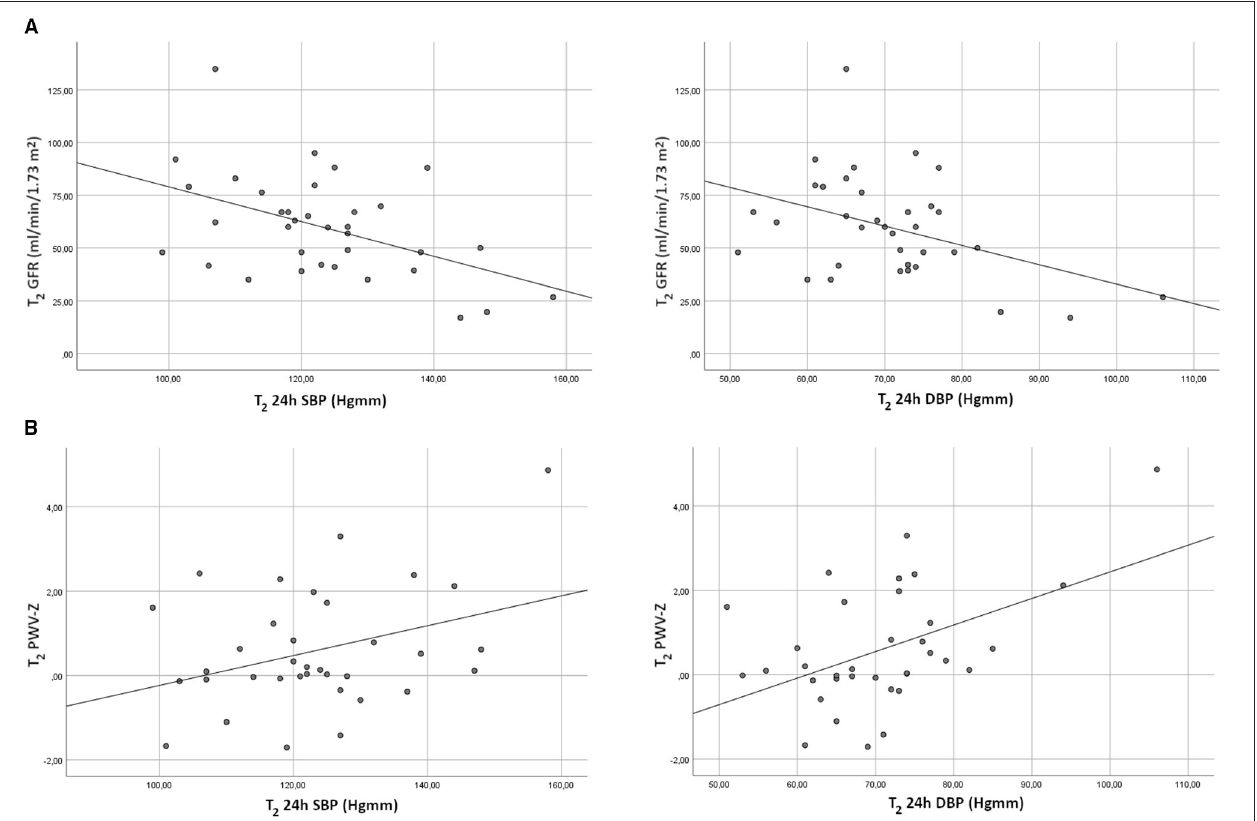
FIGURE 1 | (A) Correlation of 24 h ABPM blood pressure values and GFR at the second follow-up. GFR, glomerular filtration rate; SBP, systolic blood pressure; DBP, diastolic blood pressure. (B) Correlation of 24h ABPM blood pressure values and PWV-Z at the second follow-up. PWV, pulse wave velocity; SBP, systolic blood pressure; DBP, diastolic blood